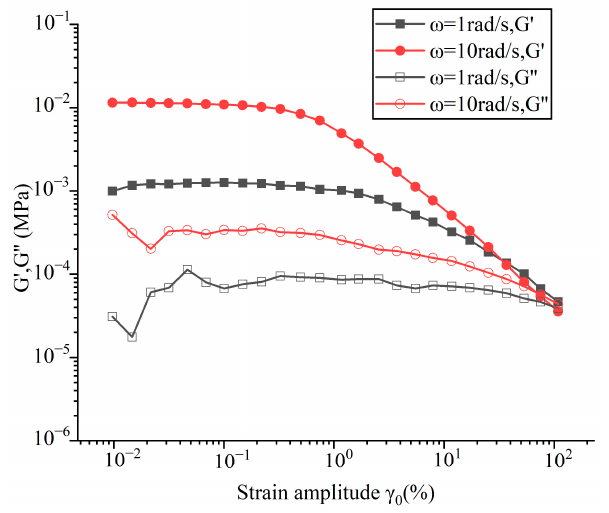
Figure 9. Storage modulus (G’) and loss modulus (G”) are plotted as a function of the strain amplitude of (Ga 80 In 10 Sn 10 ) 97 Zn 3 at 1 and 10 rad/s, respectively.